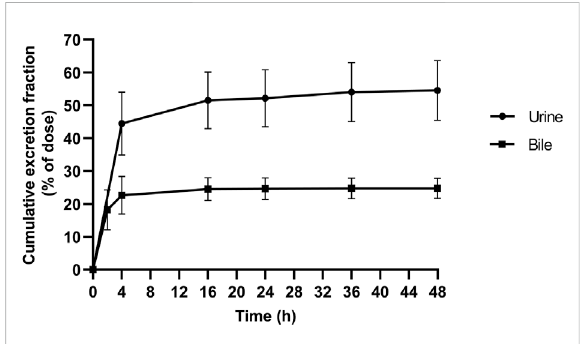
FIGURE 4 Cumulative excretion of schaftoside into urine and bile after an intravenous administration in